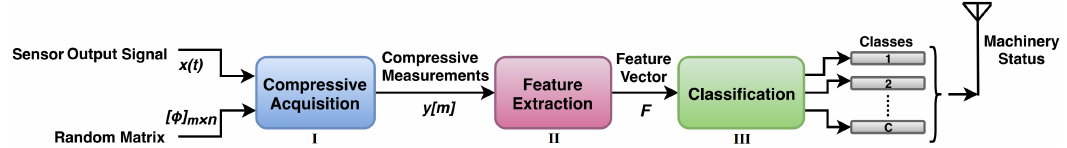
Figure 4. The proposed machinery condition monitoring scheme based on compressed signal processing (CSP) for real time fault